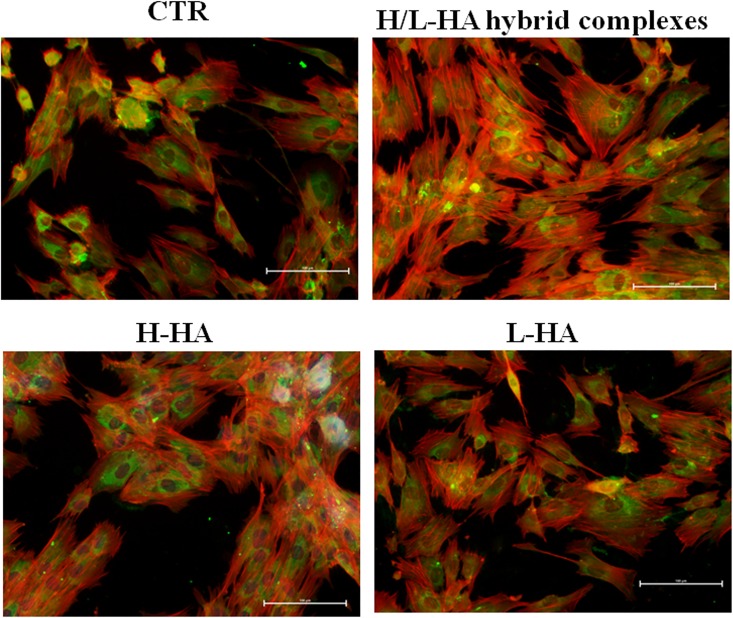
Keratinocytes-fibroblasts immunofluorescence pictures relative to COLIIIA1 expression in presence of H-HA, L-HA and H/L-HA complexes 0.16% (w/w) at 24h.Green: type III collagen, red: Cytoskeleton (Phalloidin).